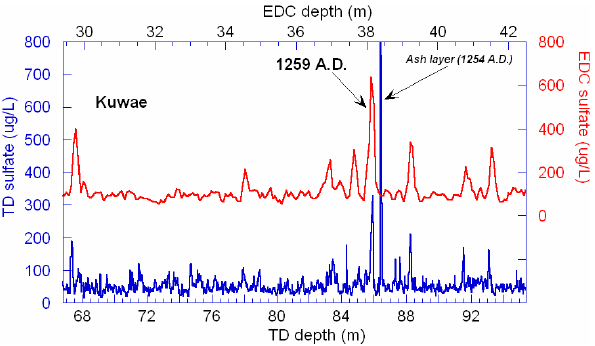
1 Figure 3. Sulphate profiles of the EDC and Talos Dome ice cores covering the period between 2 Fig. 3. Sulphate profiles of the EDC and Talos Dome ice cores cov- 1450 AD and 1130 AD. The historically known eruption of Kuwae (1453 AD) and the 1259 3 ering the period between 1450AD and 1130AD. The historically AD eruption of an unknown volcano are highlighted by arrows in the plot. An ash layer was 4 known eruption of Kuwae (1453AD) and the 1259AD eruption of found in the TD ice core together with a sharp high sulphate peak (1254 AD according to 5 an unknown volcano are highlighted by arrows in the plot. An ash Narcisi et al., 2001). 6 layer was found in the TD ice core together with a sharp high sul- phate peak (1254AD according to Narcisi et al., 2001).